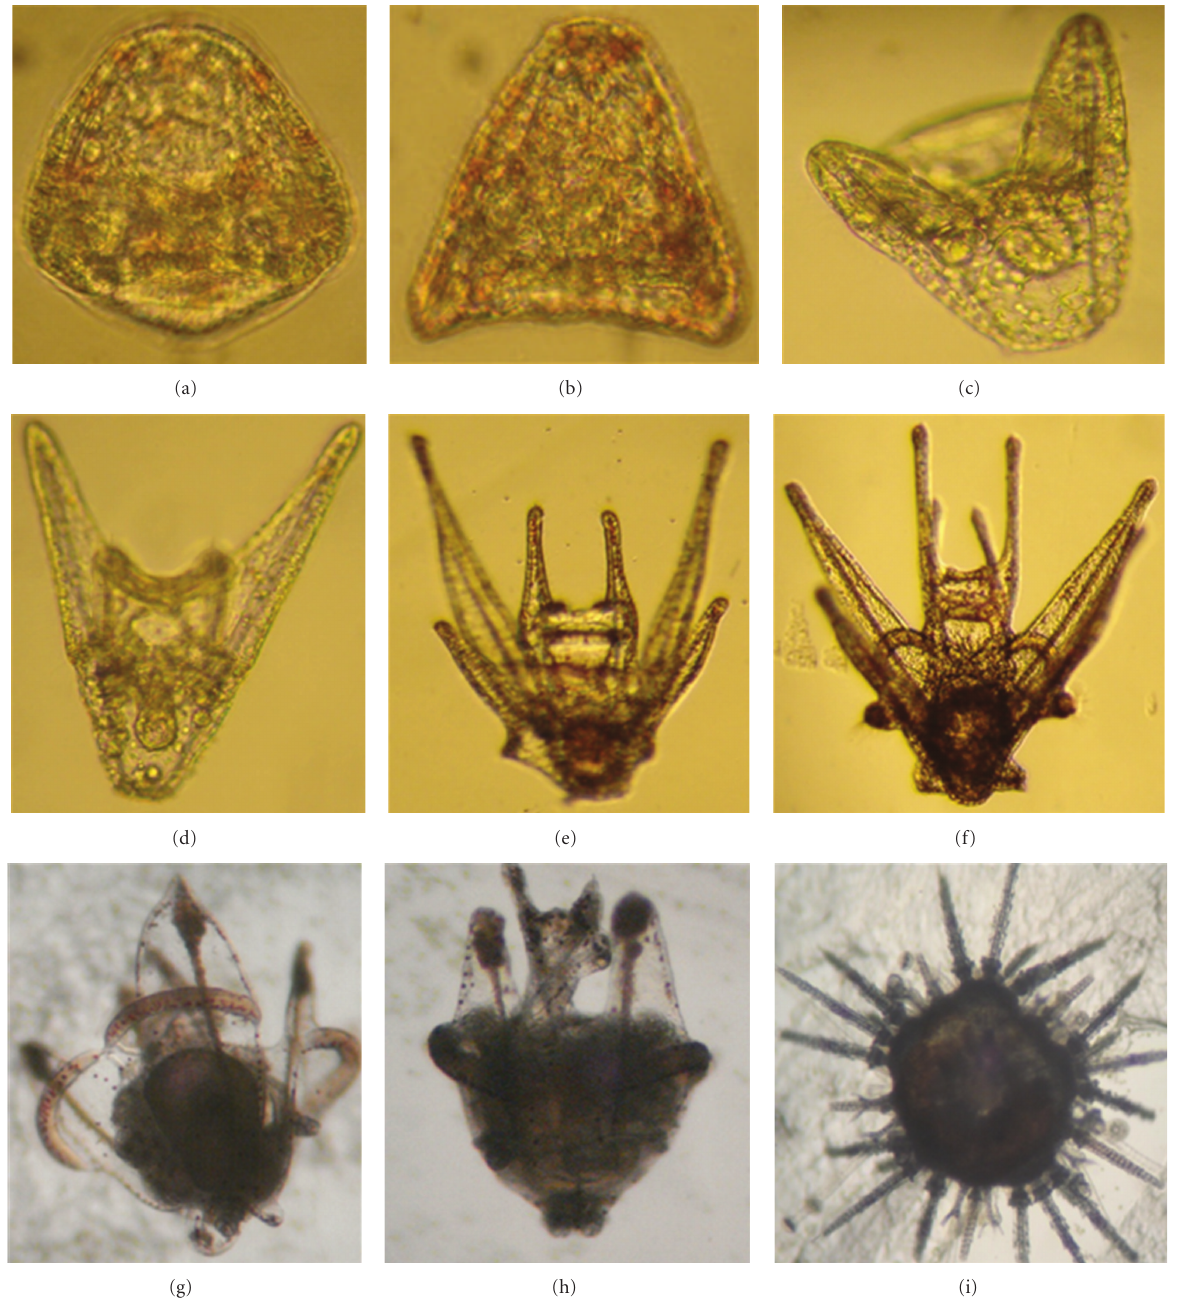
Figure 2: Larval developmental stages of S. sphaeroides under compound microscopy. (a) Gastrula, (b) Prism, (c) 2-arm pluteus, (d) 4-arm pluteus, (e) 6-arm pluteus, (f) 8-arm pluteus, (g) Pre-competent larva with ciliated ring and growing rudiment, (h) Competent larva with complete rudiment growth, (i) Juvenile (1 d after